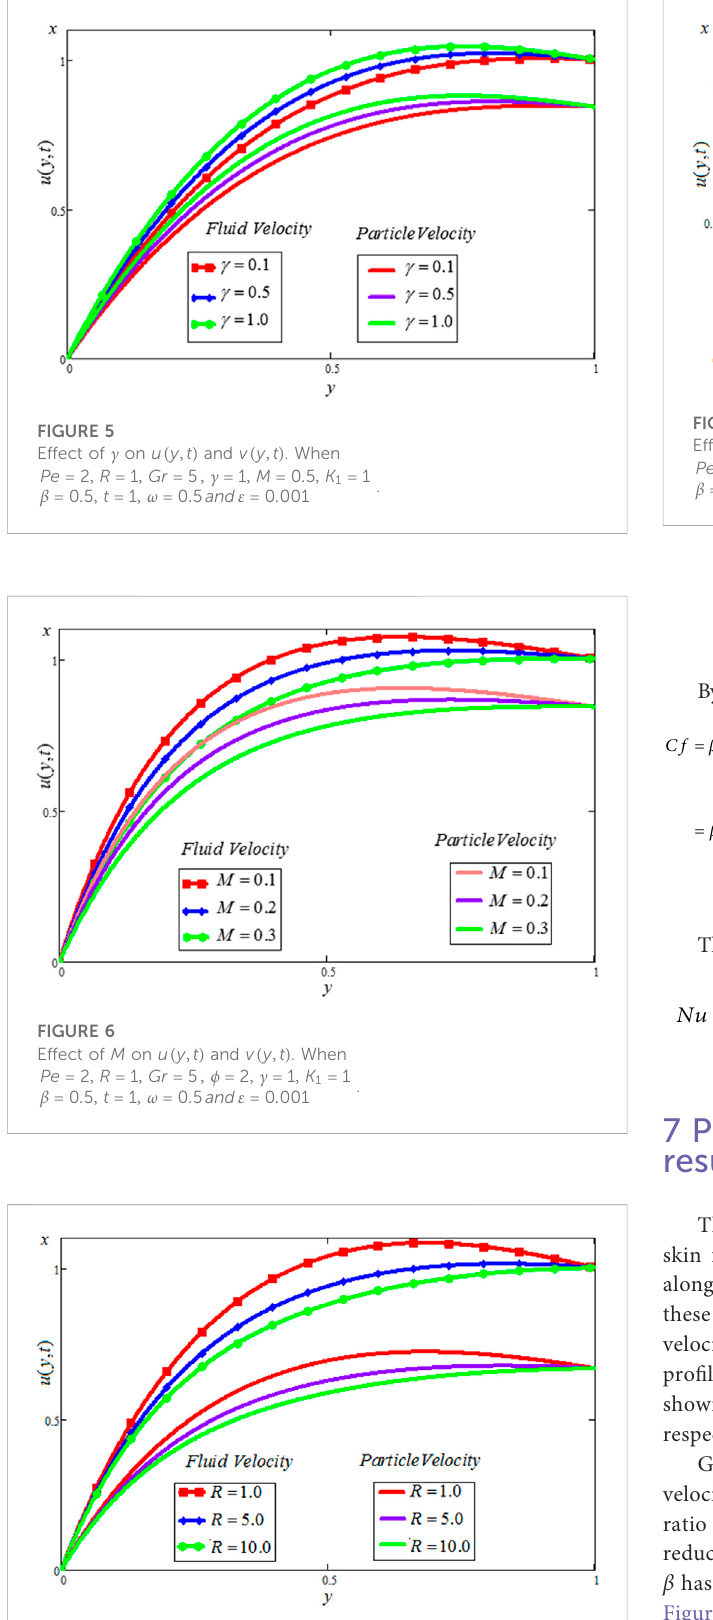
FIGURE 7 Effect of R on u ( y , t ) and v ( y , t ) . When Pe (cid:2) 2 , M (cid:2) 0 . 5 , Gr (cid:2) 5 , ϕ (cid:2) 2 , γ (cid:2) 1 , K β (cid:2) 0 . 5 , t (cid:2) 1 , ω (cid:2) 0 . 5 and ε (cid:2) 0 . 001 .